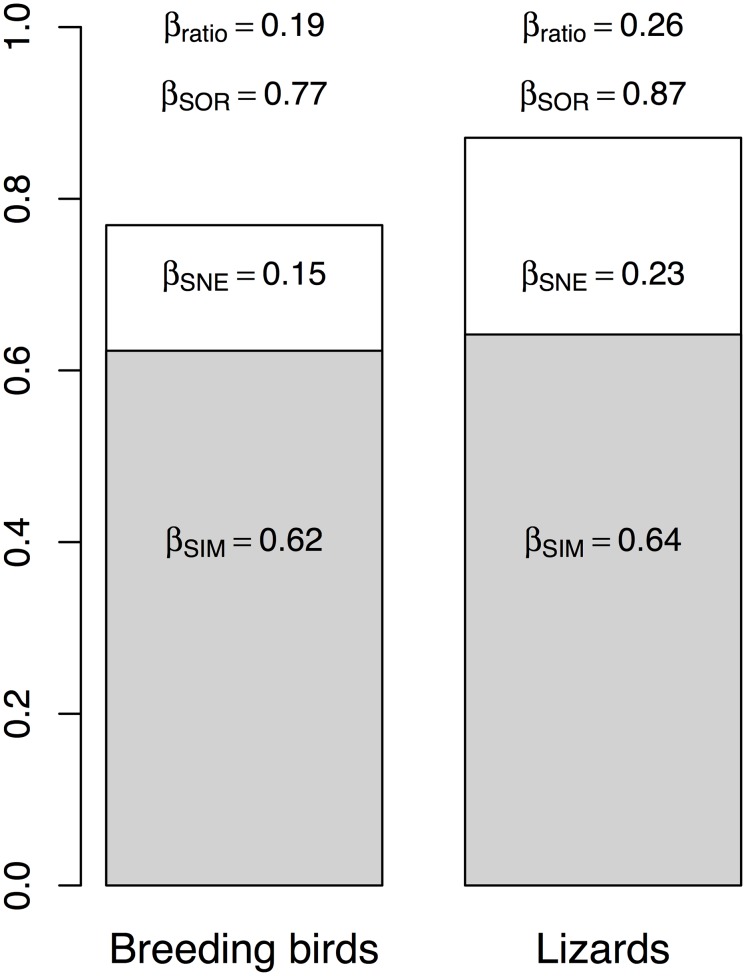
The multiple-site Sørensen dissimilarity (βSOR) and its components of turnover (βSIM) and nestedness-resultant (βSNE) of breeding bird and lizard communities on 37 study islands in the Thousand Island Lake, China.βratio indicates the ratio of βSNE to βSOR.